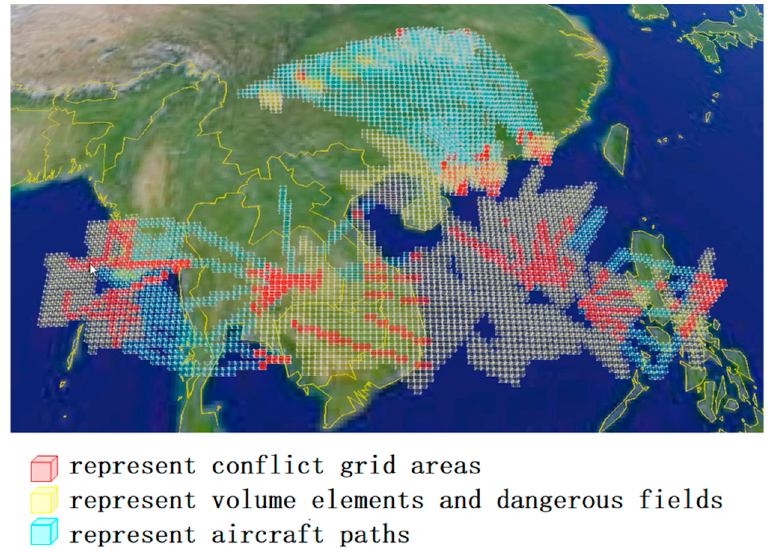
Figure 10. Results of flight conflict detection.